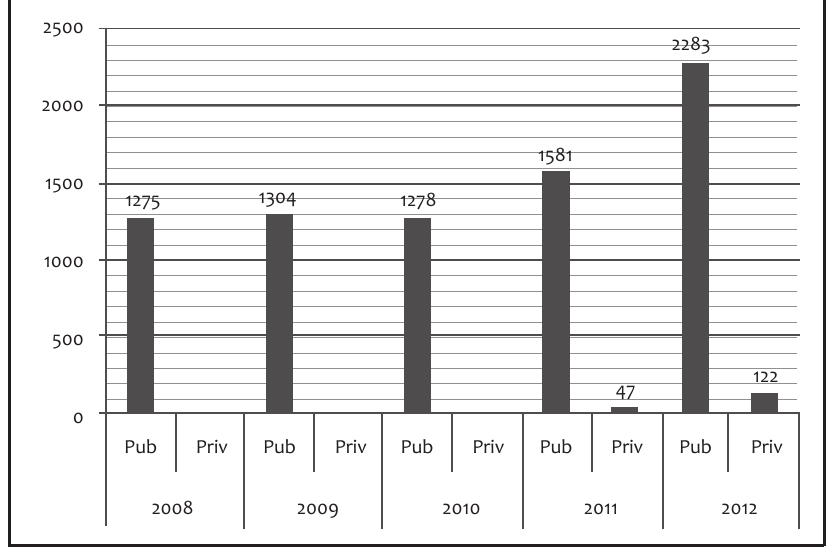
Figure 1: Number of new teacher graduates qualified to teach in the foundation phase (public and private higher education institutions, or HEIs) between 2008 and 2012. (Source: RSA DHET 2009; 2010; 2011; 2012;